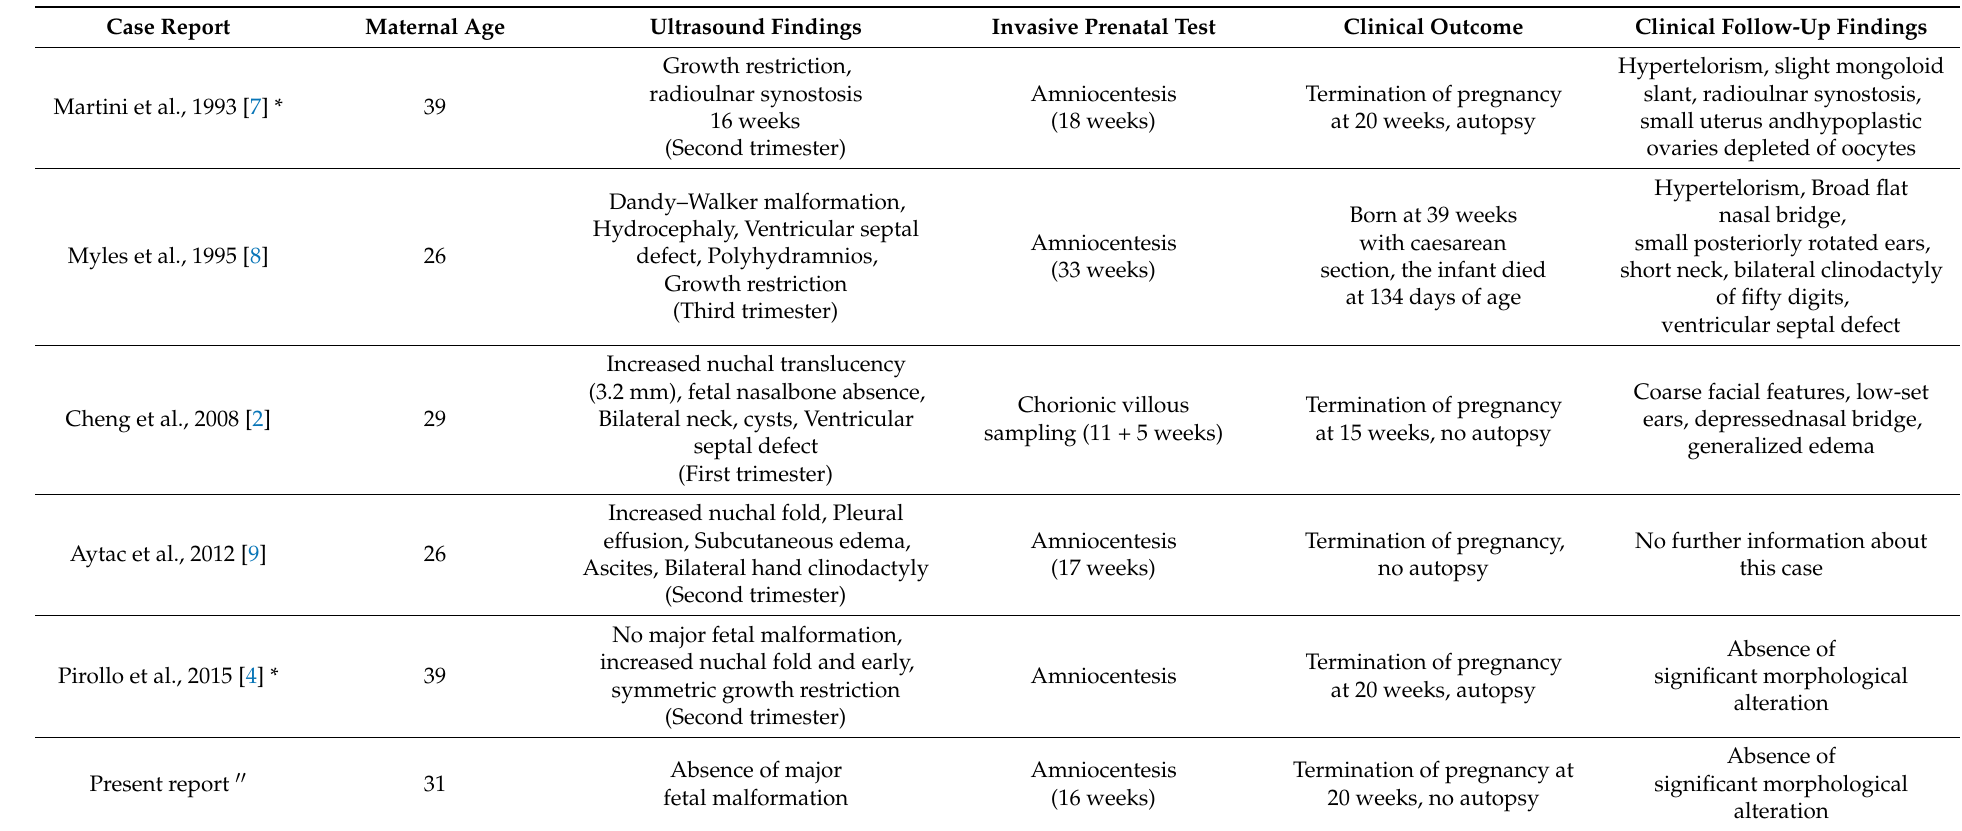
Table 1. Review of the literature: clinical features in cases prenatally